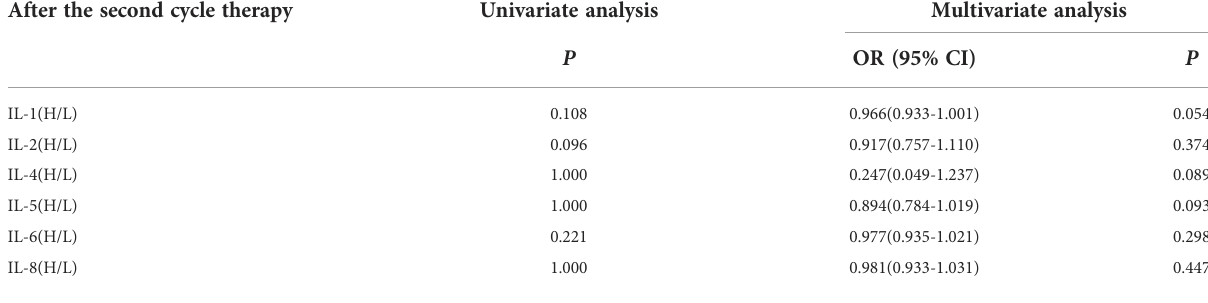
TABLE 9 Univariate and multivariate analysis results of cytokine levels after the second cycle therapy between CB and NCB. After the second cycle